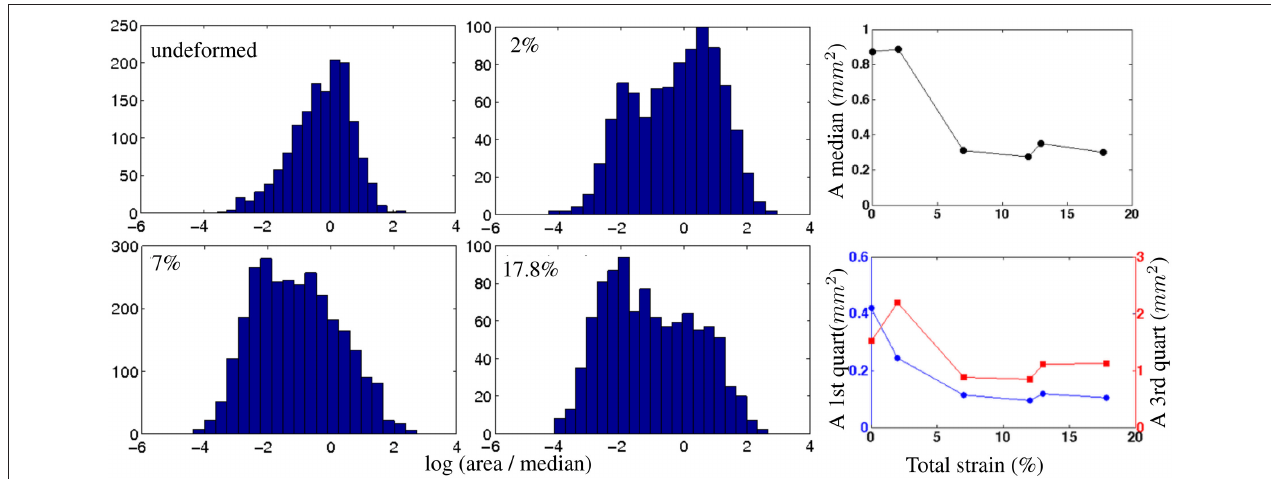
FIGURE 3 | Left: Distributions of grain area in logarithmic scale, for the undeformed sample and samples deformed to 2, 7, and 17.8% strain. Not all distributions are shown for clarity purpose. Right: 2D grain area (A) evolution with strain, determined from the AITA microstructure measurements. Median (top) and first- and third- quartiles (bottom) grain areas are represented.